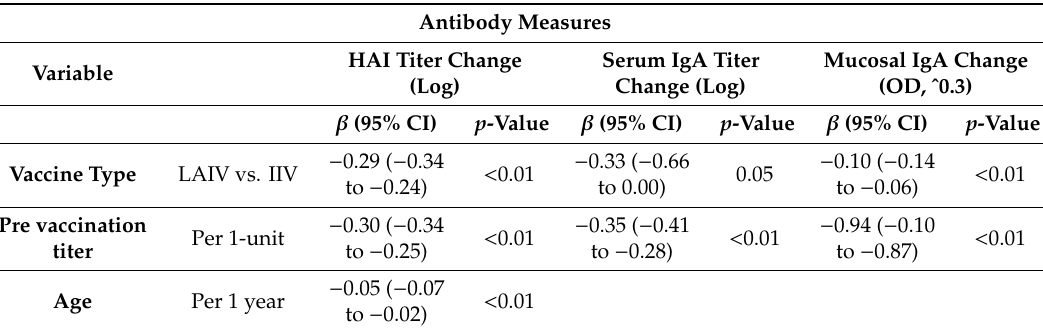
Table 3. Variables associated with antibody response to A / Texas / 50 / 2012-like H3N2.